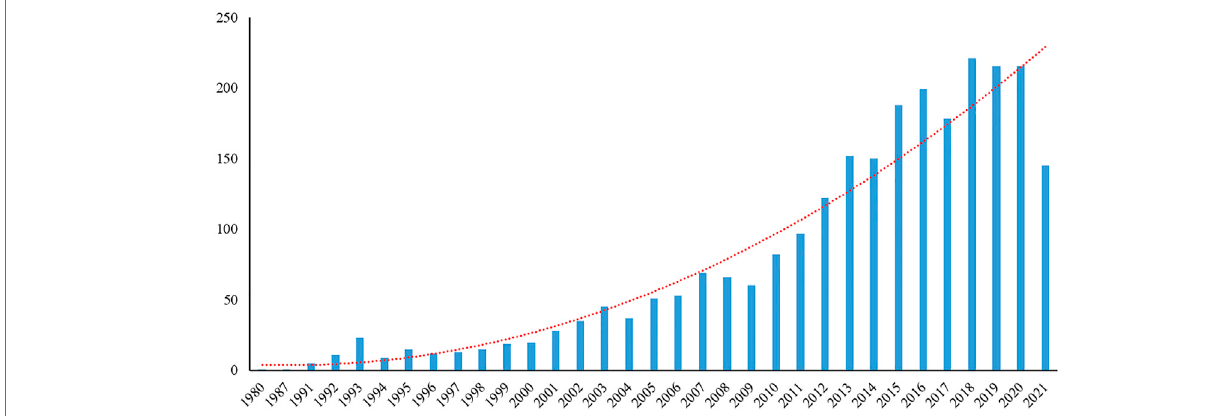
FIGURE 1 | The statistics of COPD drugs-related articles from 1980 to 2021.